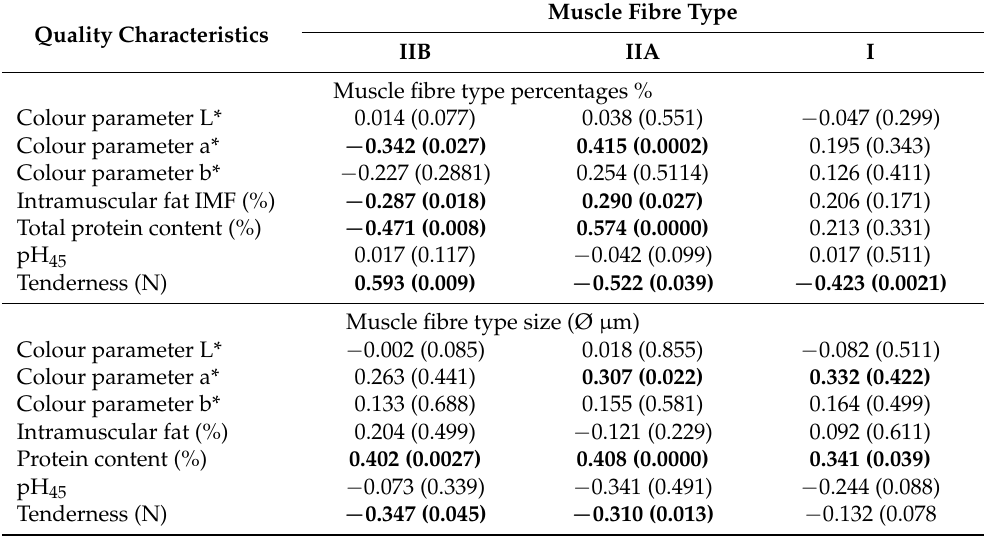
Table 9. Correlation coefficients ® between the quality characteristics of the raw smoked loin and muscle fibre percentage and fibre type